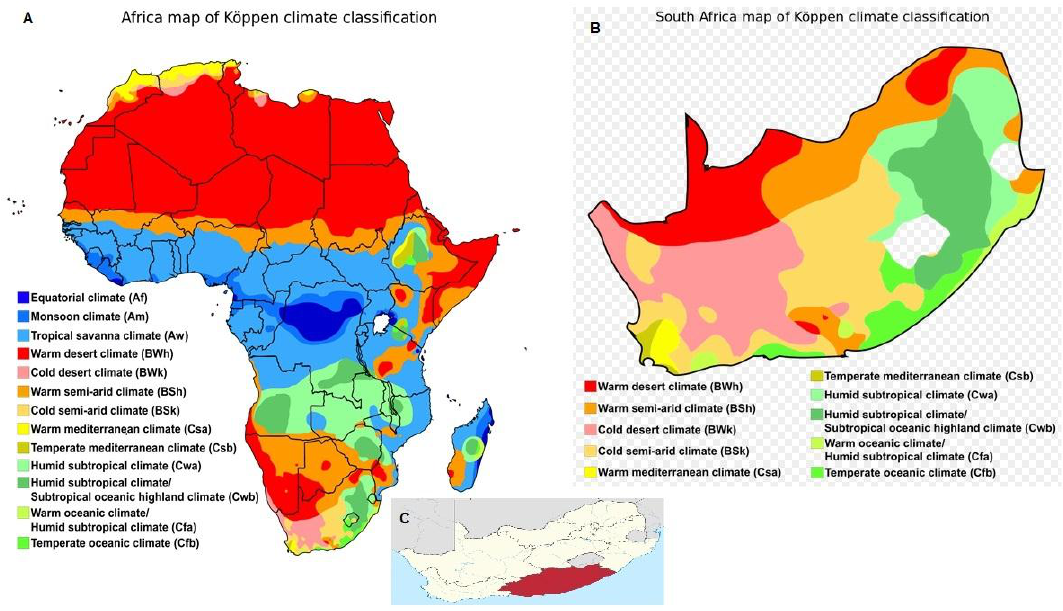
Figure 1. ( A ) Map of Africa of Koppen climate classification system; ( B ) Map of South Africa; ( C ) Map of the Eastern Cape Province (ECP) [27].